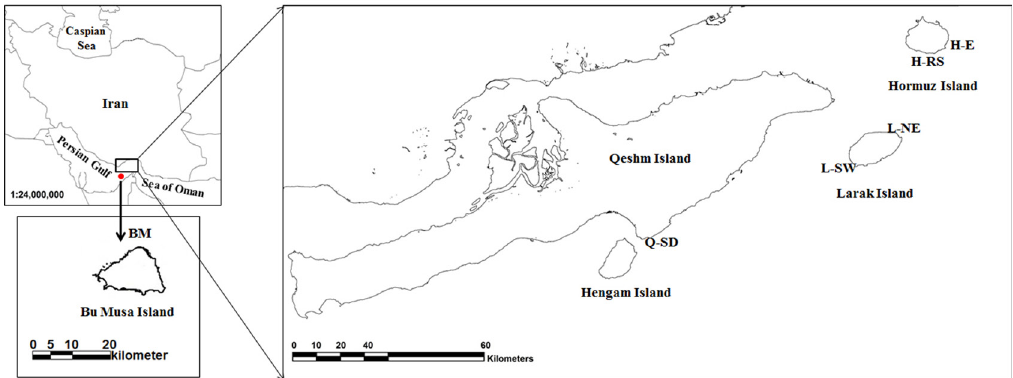
Fig. 1. – Map of sites examined in this study.